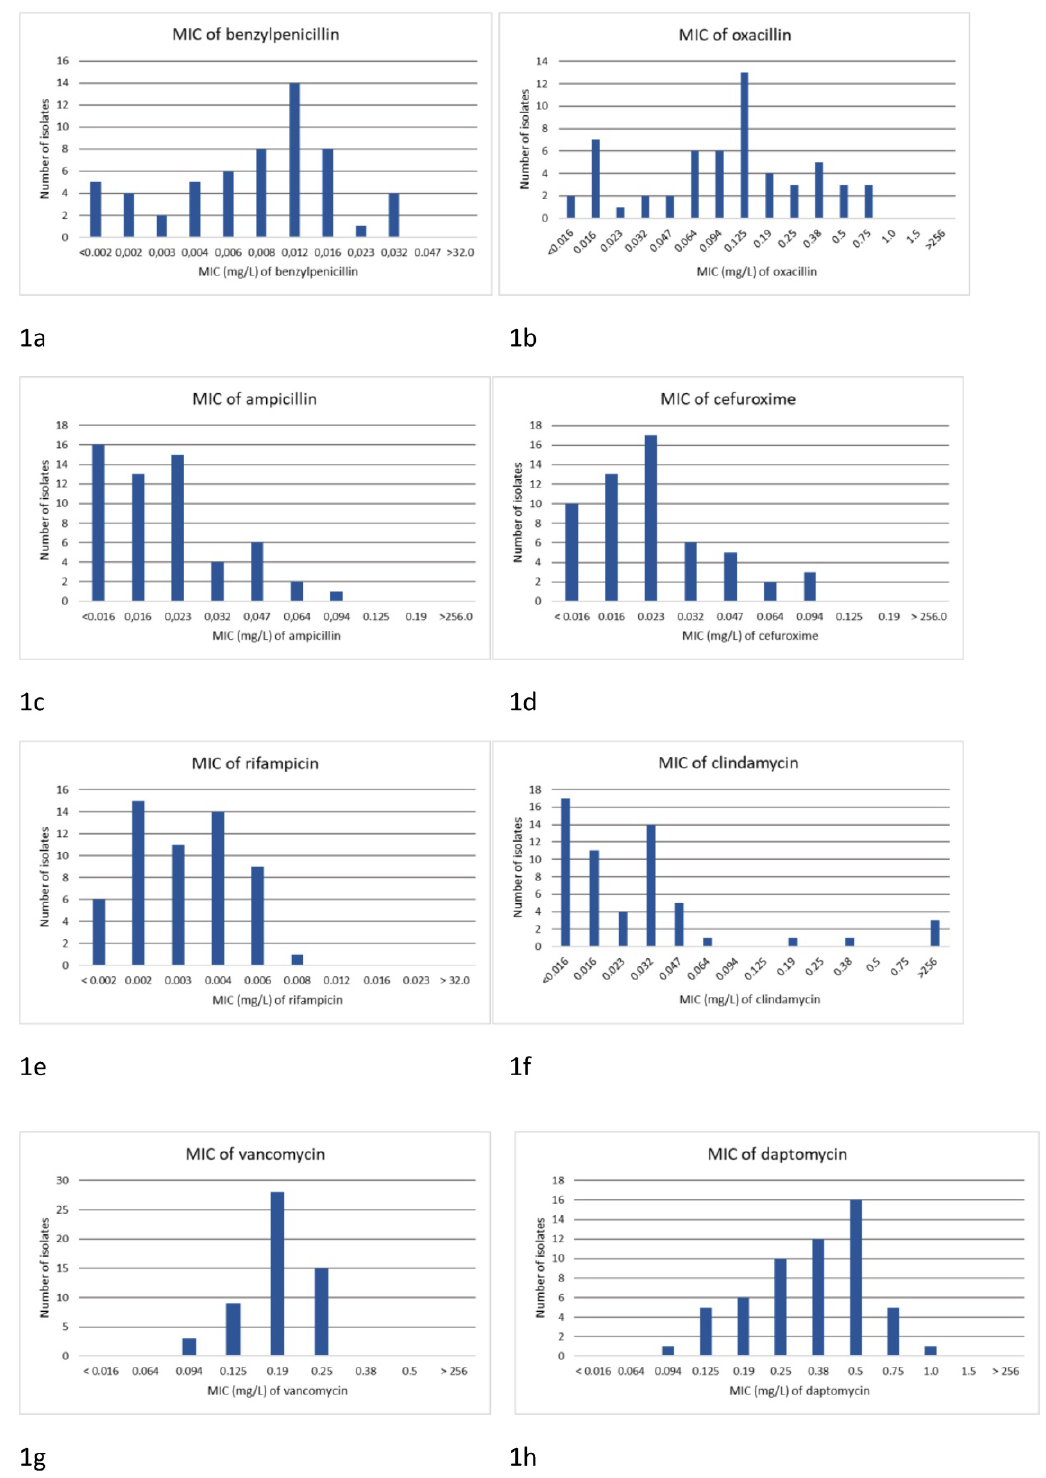
Figure 1. Distribution of MIC values determined by Etest for 57 isolates of Cutibacterium acnes obtained from orthopedic implant infections of the knee joint (n=5), hip joint (n=21), and shoulder joint (n=31) for; a) benzylpenicillin, b) oxacillin, c) ampicillin, d) cefuroxime, e) rifampicin, f) clindamycin, g) vancomycin, and h)